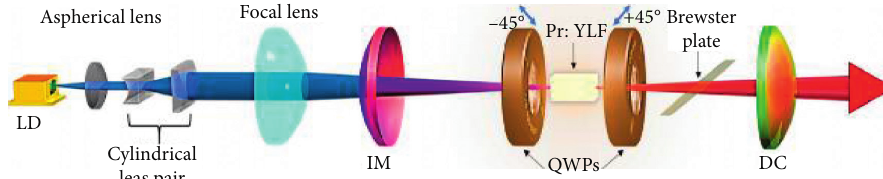
Figure 9: Schematic of SLM laser based on torsion pendulum cavity [49].